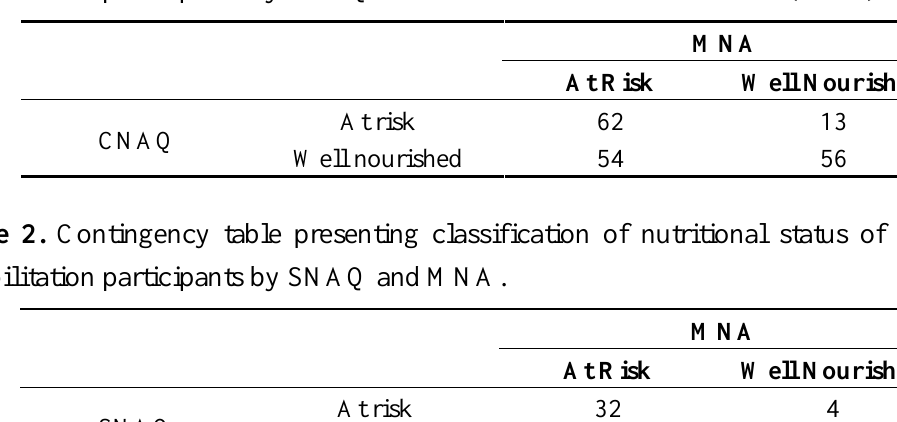
Table 1. Contingency table presenting classification of nutritional status of ambulatory rehabilitation participants by CNAQ and Mini Nutritional Assessment (MNA).